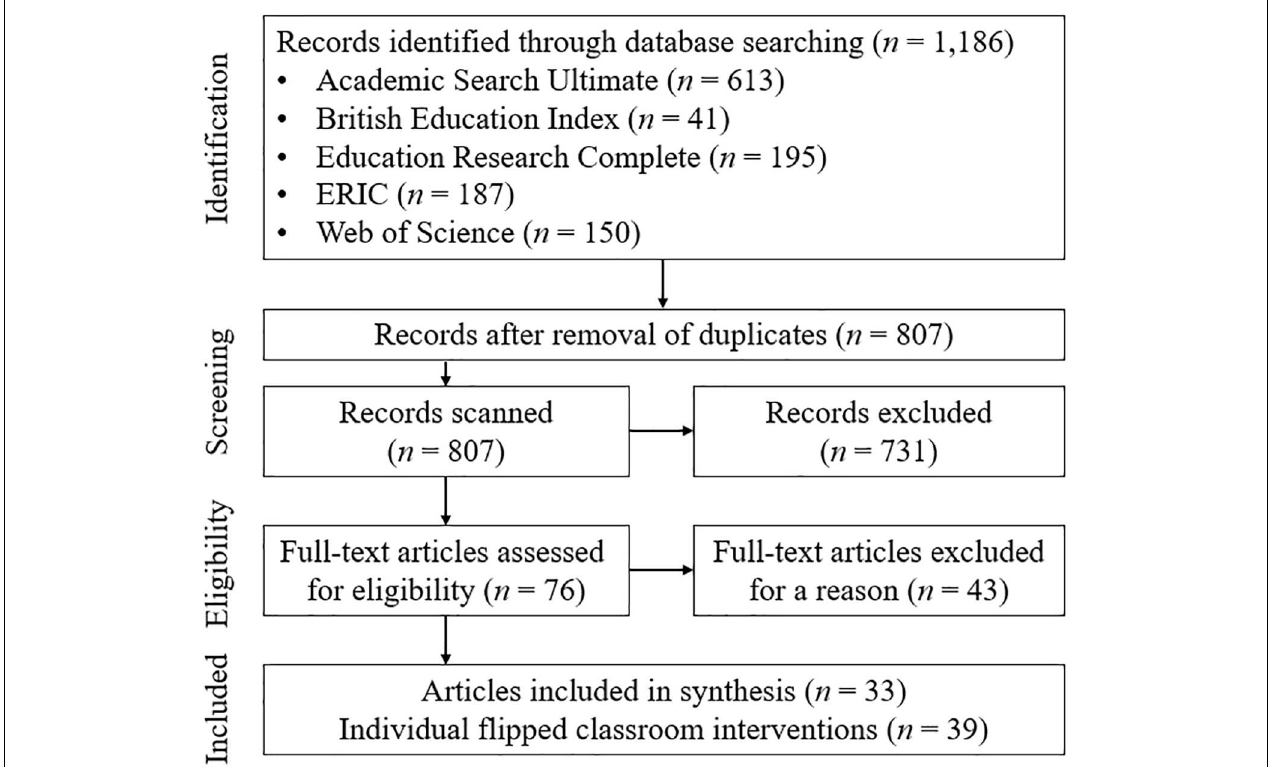
FIGURE 1 | Preferred reporting of items for systematic reviews and meta-analyses flow diagram of article